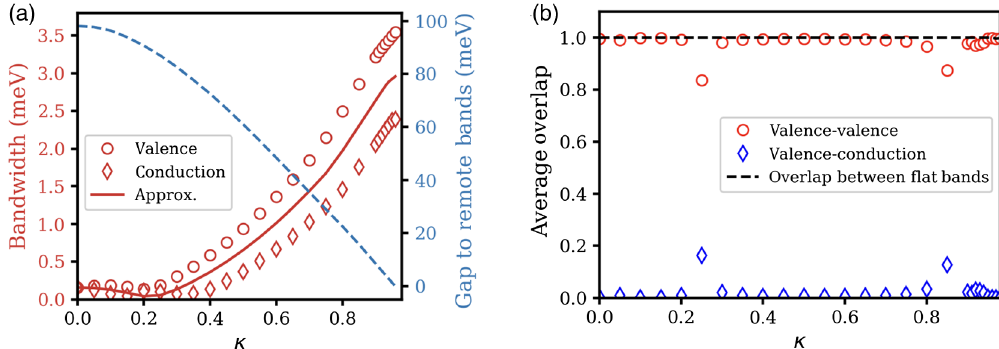
FIG. 6. Comparisons between the original BM Hamiltonian and its small-angle approximated Hamiltonian with varying κ ¼ w 0 =w 1 at θ ¼ 1 . 05 , v 2700 meV, and w 105 meV. (a) Discrepancy of the bandwidth between the original TBG model and the 0 ¼ 1 ¼ approximated chiral TBG model. Here, we also plot the gap between the conduction band and the second conduction (remote) band. Comparing left and right y axes, we notice that the flat bands are well separated from remote bands in the wide range of κ . (b) Wave- function overlaps between the original BM model and the small-angle approximated BM model for valence bands, valence-conduction bands, and flat-band subspaces. As a whole, flat-band subspaces between two Hamiltonians are almost identical until the gap to remote bands closes at around κ ¼ 1